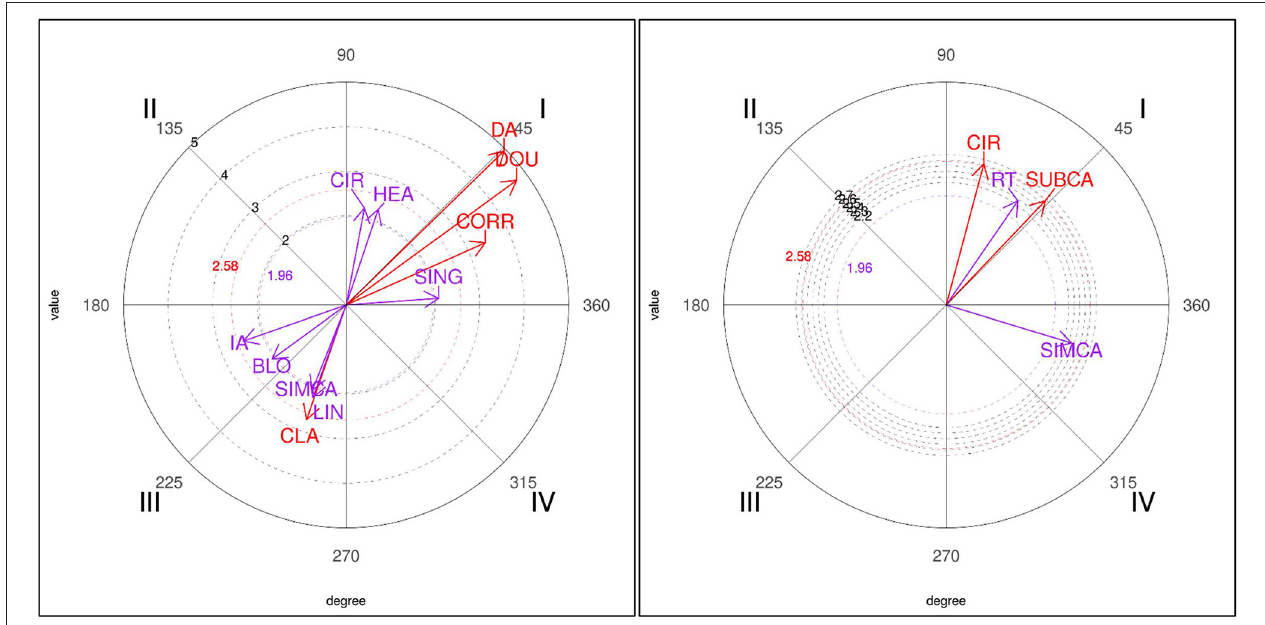
FIGURE 1 | Representation of the behavioral map for the 1P focal behavior in winners (left) and losers